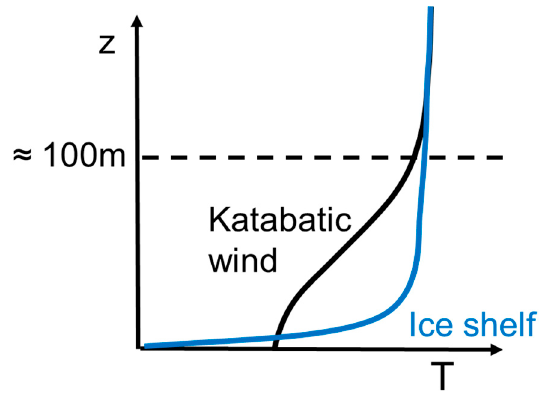
Figure 2. Schematics of the vertical temperature structure in the katabatic wind (black line) and a weak-wind ice surface (blue line).